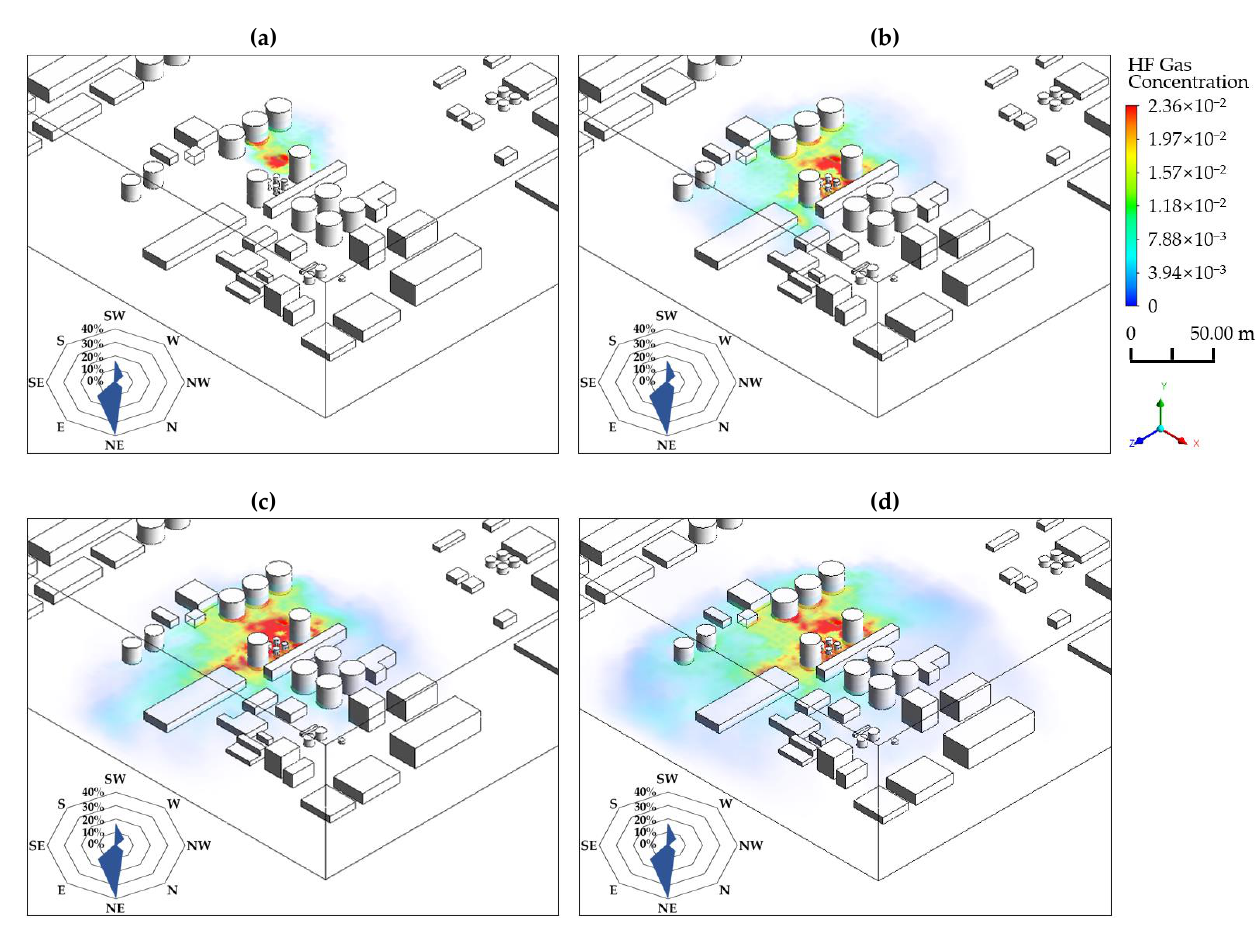
Figure 1. Changes in hydrogen fluoride (HF) three-dimensional concentration distribution with time when the wind speed is 1 m/s (the x-axis represents the north direction, and the z-axis represents the east direction): ( a ) t = 60 s; ( b ) t = 240 s; ( c ) t = 420 s; ( d ) t = 600 s.